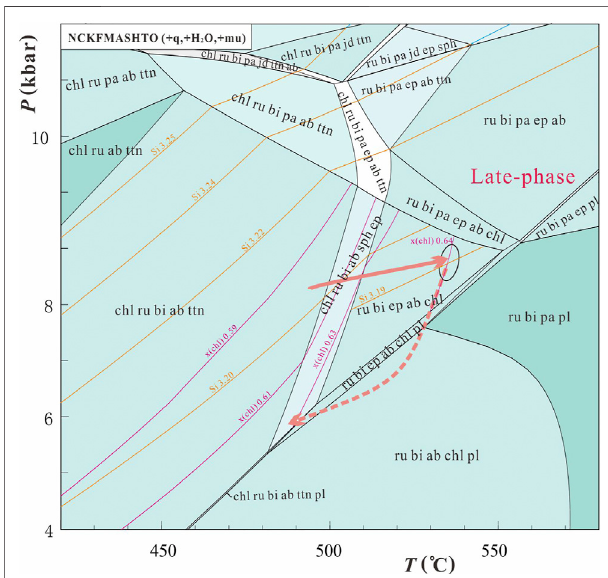
FIGURE 7 | P – T pseudosection for sample EL01 calculated in the NCKFMASHTO (+q, H 2 O, mu) using an effective bulk composition generated accordingtomassbalanceconstraintsbyexcludingthecompositionofgarnet and integrating mineral compositions and modal abundance data of the other phases, normalized on the basis of mole-proportions as: SiO 2 = 79.44, Al 2 O 3 =7.95,CaO=0.52,MgO=4.57,FeO=3.60,K 2 O=1.93,Na 2 O=1.63, TiO 2 = 0.68, and O = 0.09 (mol%). The pseudosections show isopleths of Si content in muscovite and x (chl) { = Mg/(Fe 2+ + Mg)} for relevant mineral assemblages.